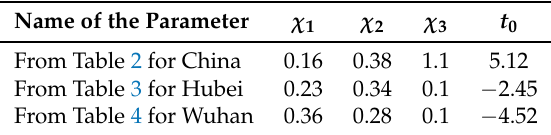
Table 5. Estimation of the parameters χ 1 , χ 2 , χ 3 , and t 0 by using the cumulated reported cases in Tables 2–4.